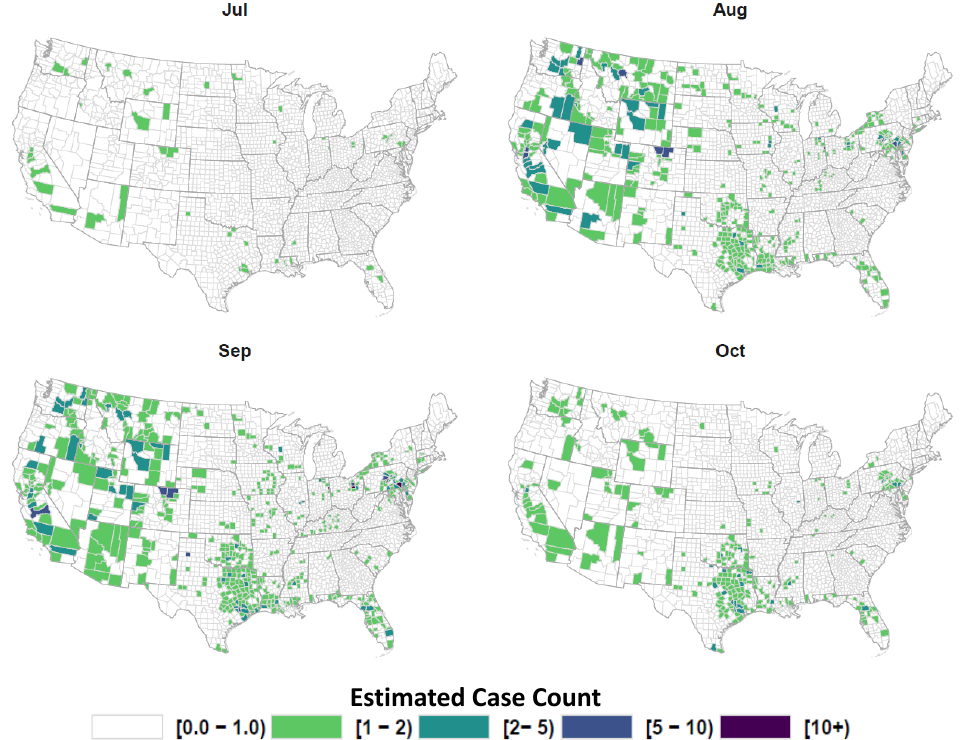
Figure A18. Estimated equine WND case counts. Maps depict the spatial and temporal distribution of model estimated WND cases by US County for select months during the peak WND outbreak season. Maps are color coded according to legend at bottom such that darker tones signify increased case loads and lighter tones represent relatively lower case counts. Case counts for all months of the year are provided with Appendix A (see Figure